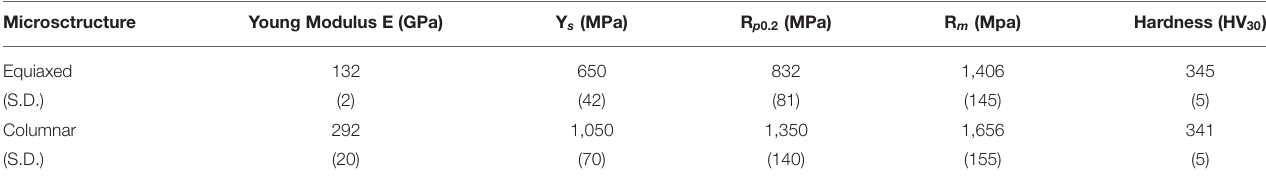
TABLE 1 | Average values obtained from the compression and hardness tests (S.D., standard deviation deduced from the three specimens tested for each type of microstructure).